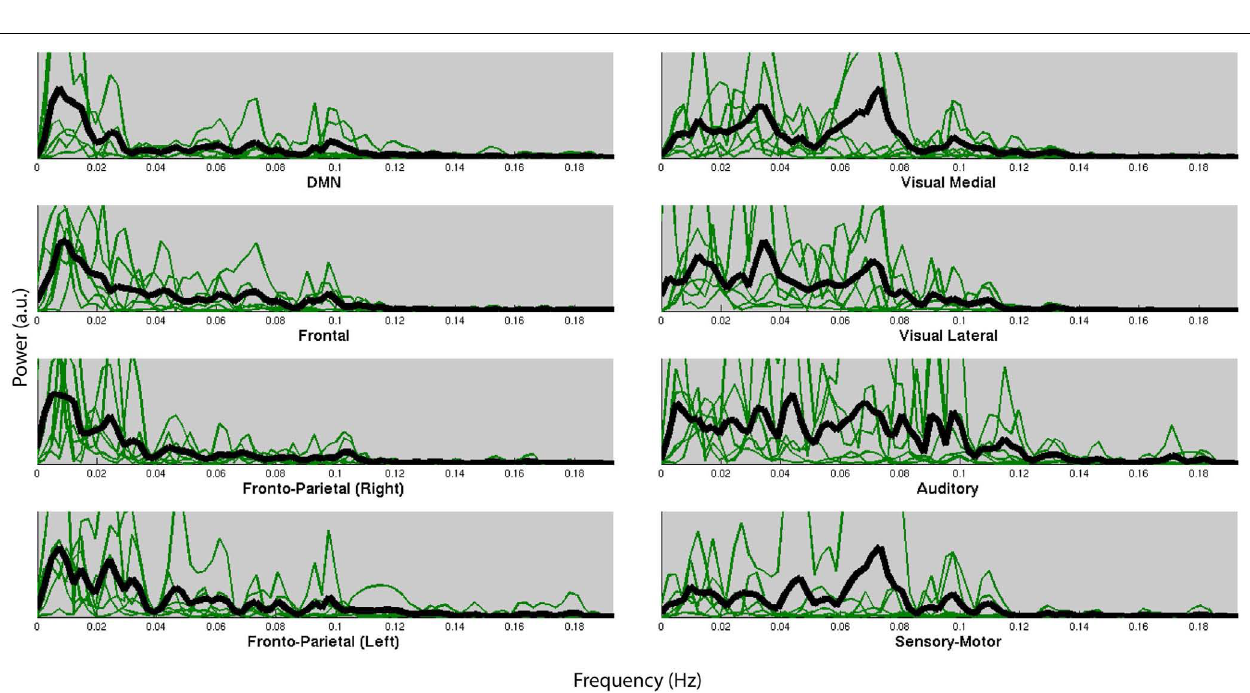
FIGURE 5 | Normalized frequency spectra of all RSNs (in green) and their average over subjects (in black) for each of the 8 RSNs up to 0.2Hz . RSNs do not have specific frequencies associated with all the subjects.